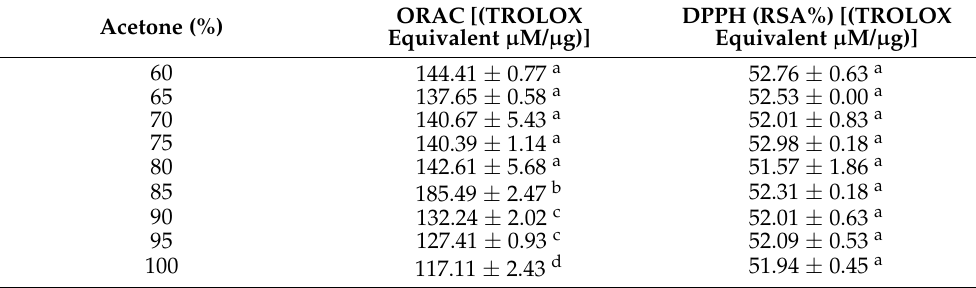
Table 3. Antioxidant activity by ORAC and DPPH assay in Quince fruit ( Cydonia oblonga Mill.) extracts. ORAC [(TROLOX Acetone (%) Equivalent µ M/ µ